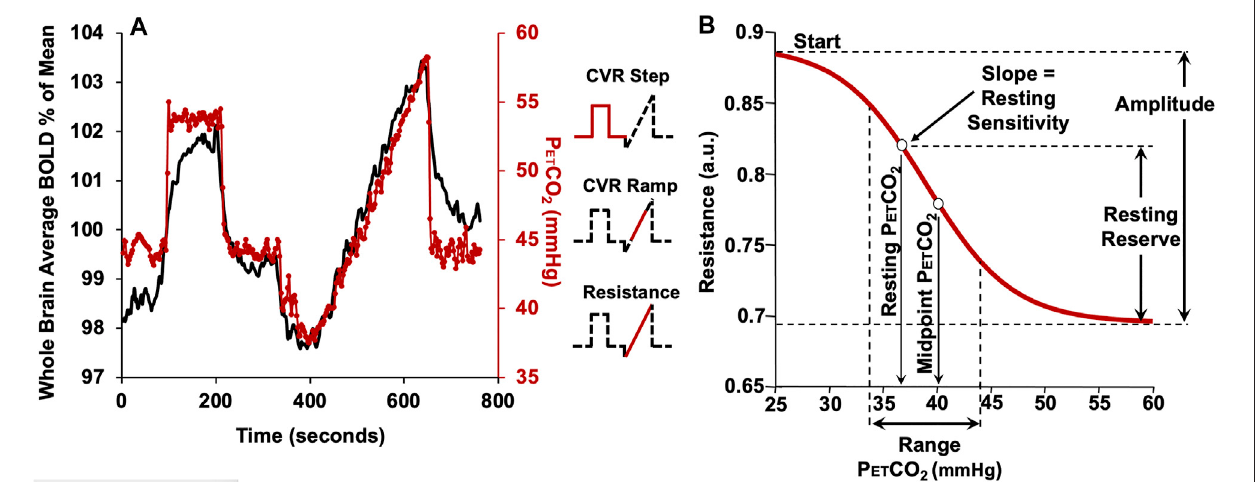
FIGURE2| TheCVR protocolinarepresentative subject. (A) TheCO 2 stimulus(redline)and wholebrainaverageBOLDresponse(black line).Thepartialpressure ofCO 2 (PETCO 2 )isclampedatthesubject ’ srestingPETCO 2 for2 min, followedbyastepincreaseinPETCO 2 to10 mmHgaboverestingfor2 min , followedbyareturn to the subject ’ s baseline PETCO 2 for 2 min. The PETCO 2 is then reduced by 10 mmHg from the subjects resting level by asking the subject to voluntarily hyperventilate for 1 min, followed by a steady rise in PETCO 2 (ramp) to 15 mmHg above the resting level over 4.5 min. PETCO 2 then rapidly returns to baseline for 2 min. The insetsshowtheportionoftheprotocolusedforvariousanalyses. (B) Theresistancesigmoidandthesigmoidparametersandderivedmetrics.Start:arelativemeasureof thevasoconstrictive fl owlimitintermsofresistance.Amplitude:ameasureofthemaximumextentofresistancechanges.Midpoint:ameasureofthedisplacementofthe response with respect to CO 2 . Range: a measure of the CO 2 range where the resistance response is linear. Sensitivity at resting PETCO 2 : the slope of the straight segment of the sigmoid as an alternate measure of resting state CVR in terms of resistance. Resting reserve: the vasodilatory reserve at resting PETCO 2 (From Duf fi n et al., 2017).